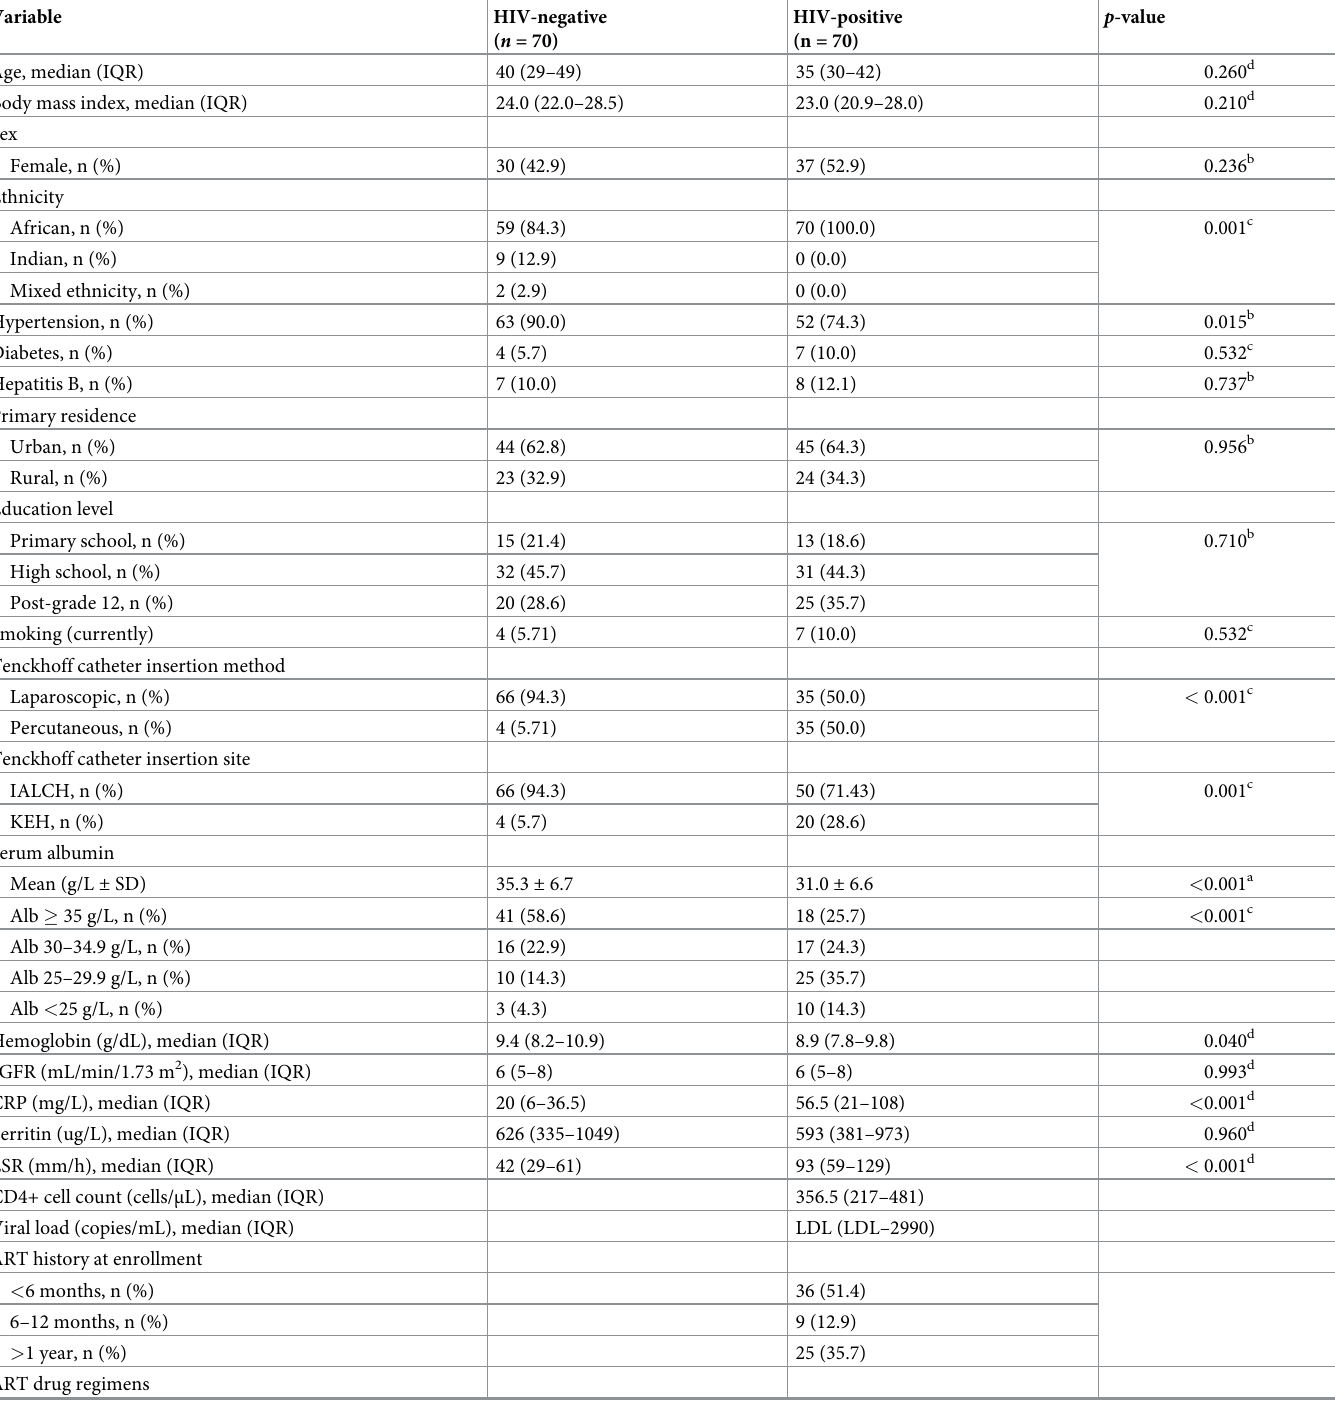
Table 1. Baseline characteristics according to HIV